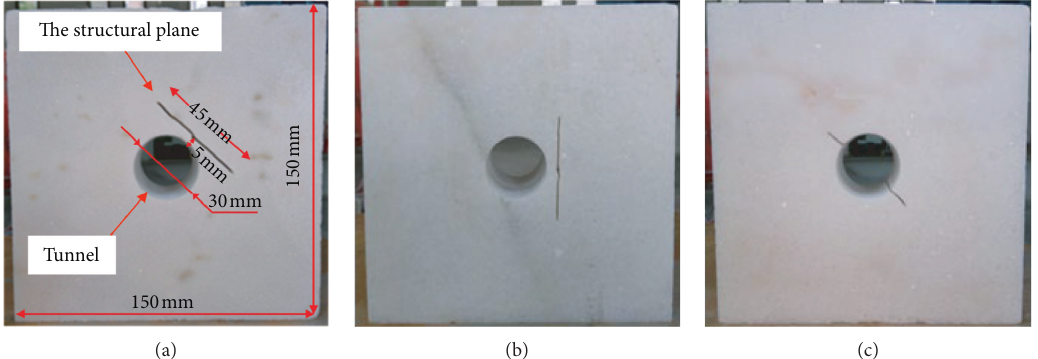
Figure 2: Three types of marble model samples. (a) The structural plane located in the tunnel spandrel. (b) The structural plane located in the tunnel sidewall. (c) The structural plane intersected with the tunnel.